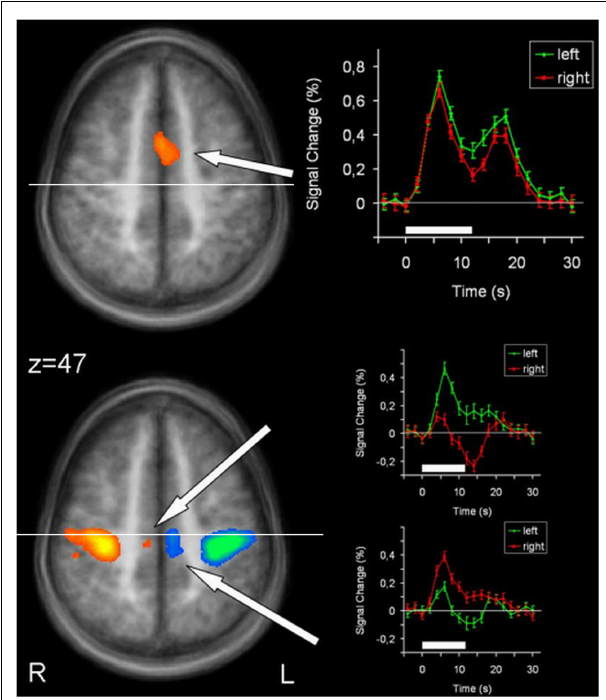
FIGURE 2 | Conjunction analysis (top) and contrast analysis (bottom) of left and right hand finger movements . In the contrast analysis, regions more active during left hand movement are labeled in yellow/orange, those more active during right hand movement are labeled in green/blue. Time courses represent from top to bottom signal changes of rostral SMA and caudal SMA, for left hand (green) and right hand (red) finger tapping. The white bars indicate the interval of the movement condition. The white line indicates the level of the VPC-line ( y = (cid:0) 22). p < 0.001. L, left; R, right. The Talairach coordinate in millimeter is